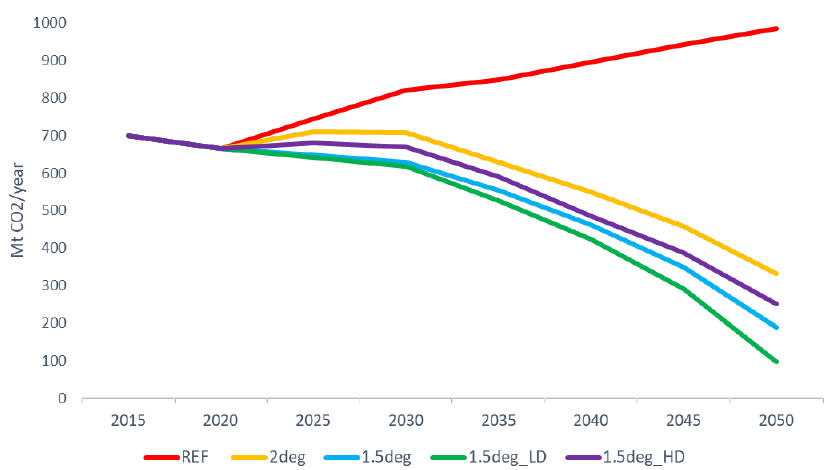
Figure 9. CO 2 emissions from international shipping over 2020 – 2050.